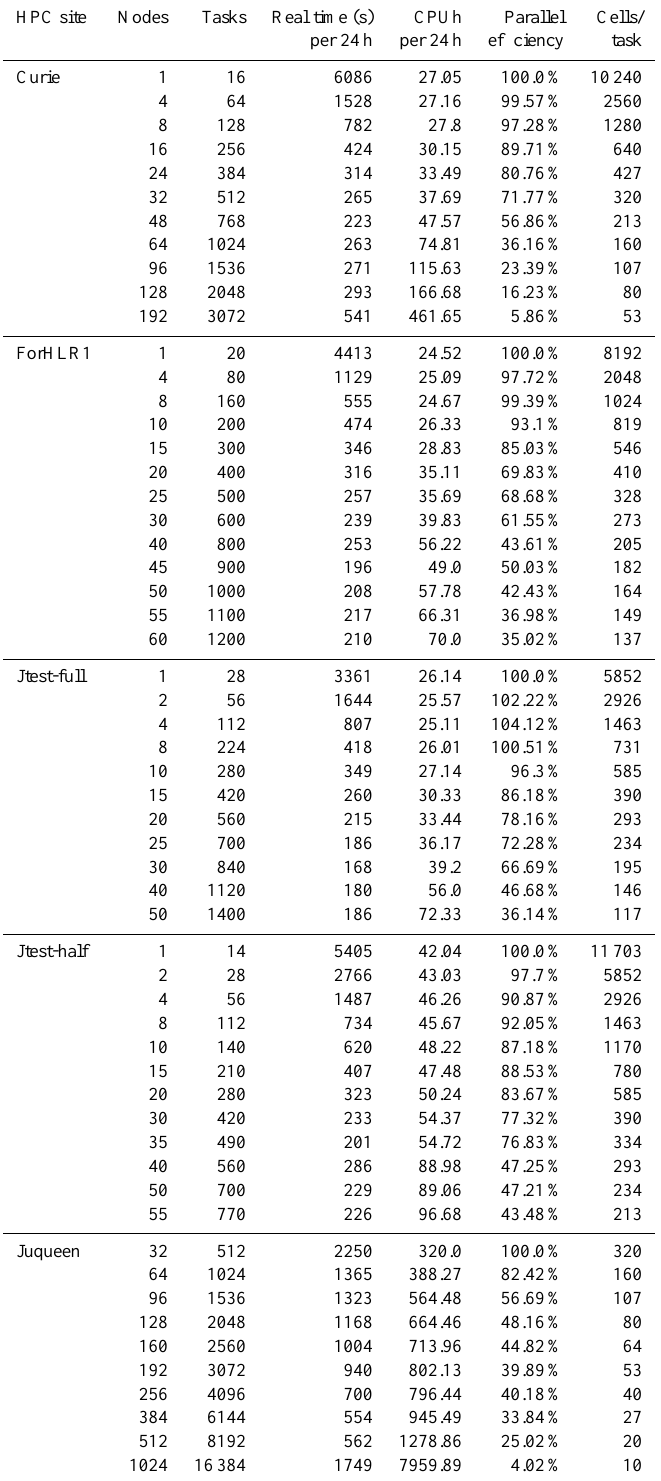
Table E1. Scaling tests for the 100–25km variable mesh on the four HPC